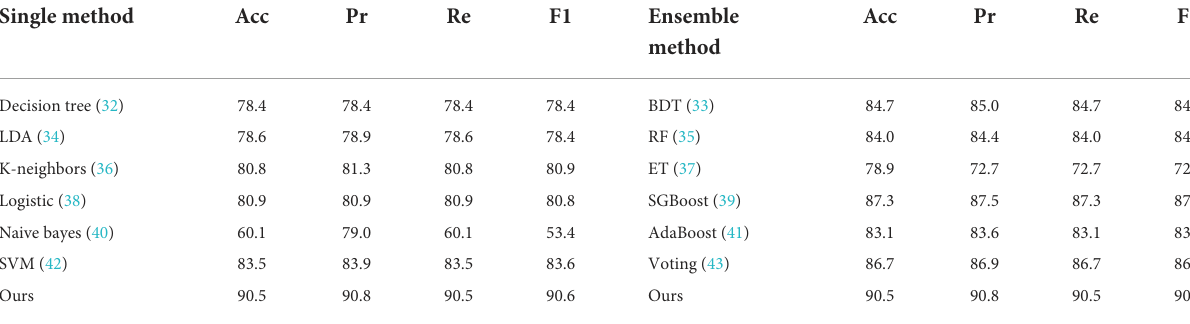
TABLE 2 Classification results (%) with evaluation metrics of different methods on 13-dimensional features.